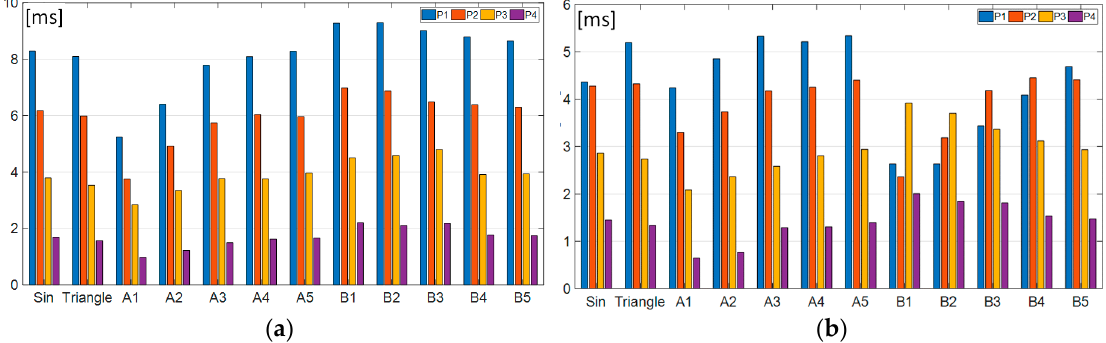
Figure 8. Average arcing times T a of: ( a ) CI-1 ( b ) CI-2 measured for voltage waveforms.